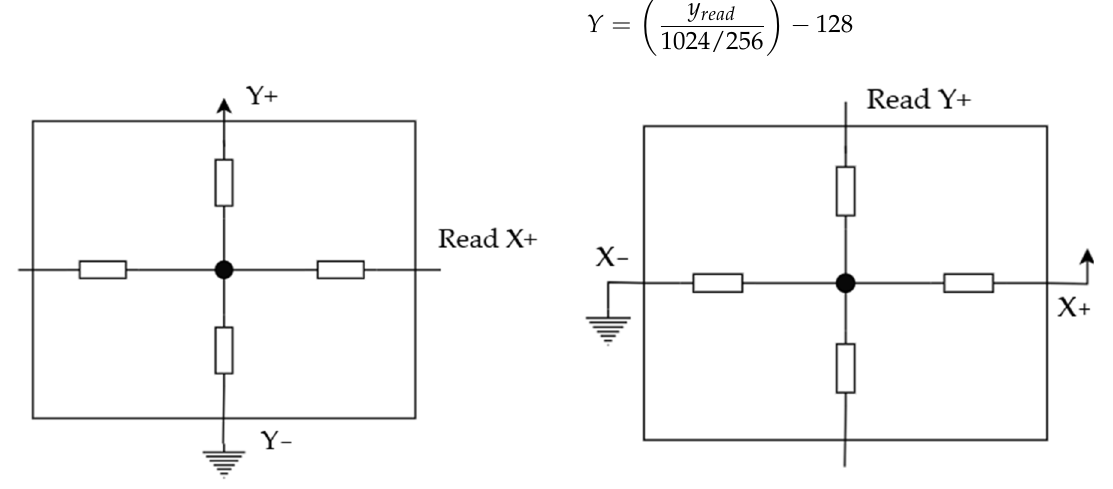
Figure 5. Resistive touch-screen wiring diagram.